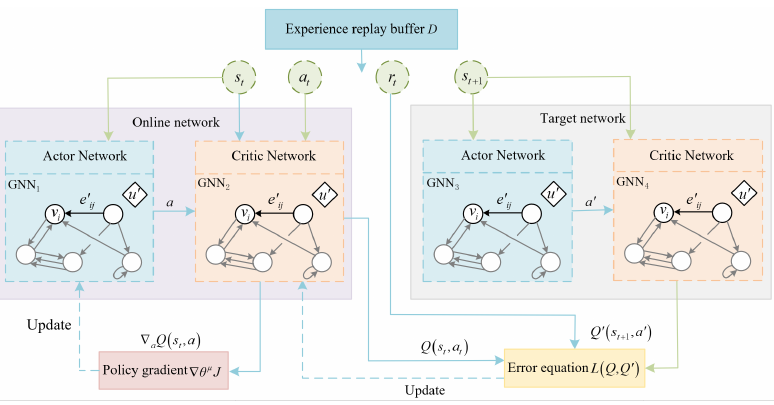
Figure 3. GNN-DRL algorithm